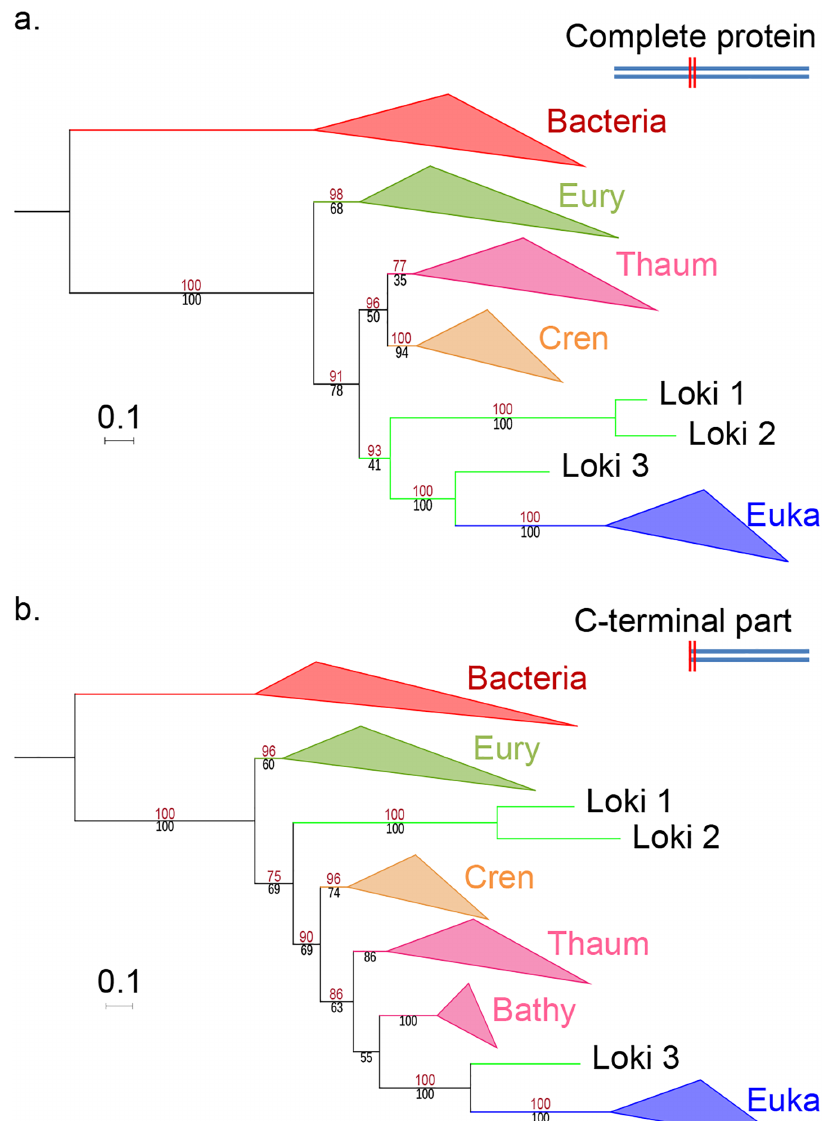
Fig 3. EF2 phylogenetic trees, based on the curated dataset after inclusion of bathyarchaeal sequences. a. ML phylogenetic tree of the completesequence(626 positions). b. ML phylogenetic tree of the C-terminal part only (394 positions). Eury, Thaum, Cren and Euka stand for Euryarchaeota, Thaumarchaeota, Crenarchaeota and Eukaryotes. Detailedtrees in S17 and S18 Figs. The scale-barsrepresent the average numberof substitutionsper site. Values at nodesrepresent support calculatedby nonparametric bootstrap (out of 100) and ultrafast bootstrapapproximation (1,000 replicates), in black and red, respectively.